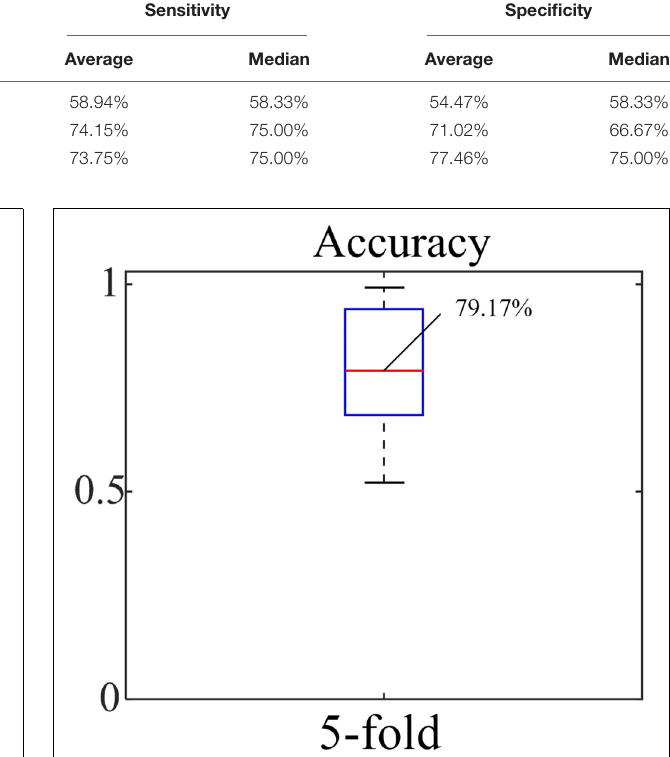
FIGURE 9 | Average accuracy by 5-fold cross